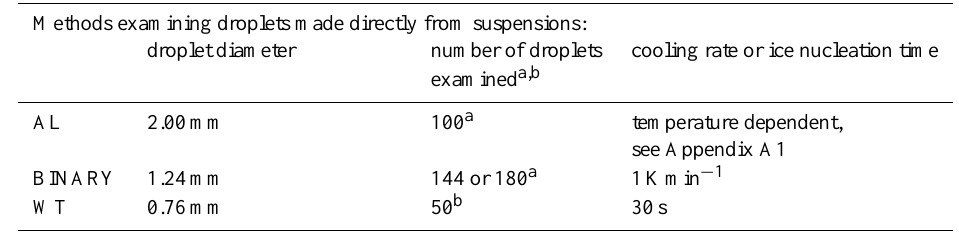
see Appendix A1